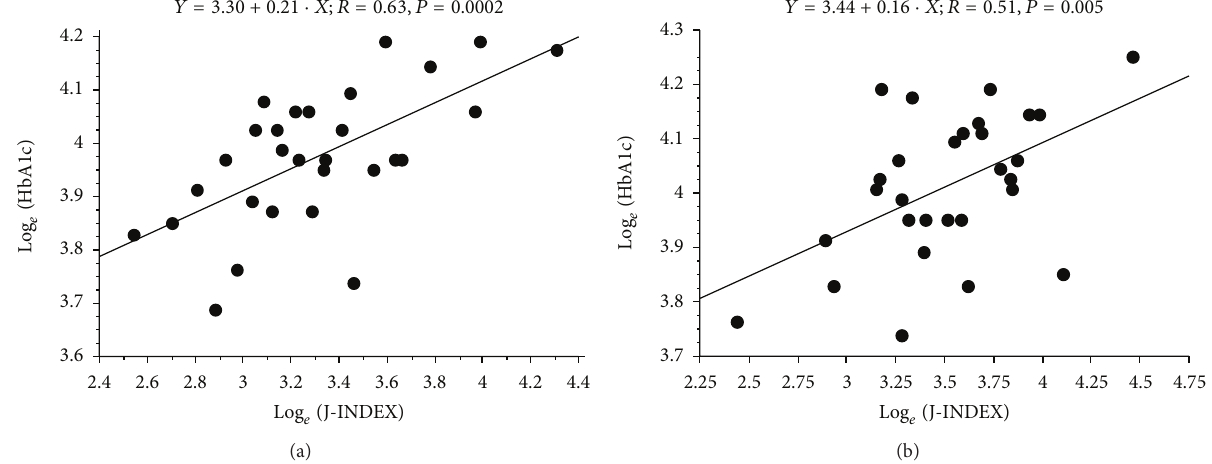
Figure 2: Relationships between an index of glycemic variability (J-INDEX) and glycated hemoglobin after treatment, in the case of vildagliptin (a) and placebo (b). Variables were logarithmically